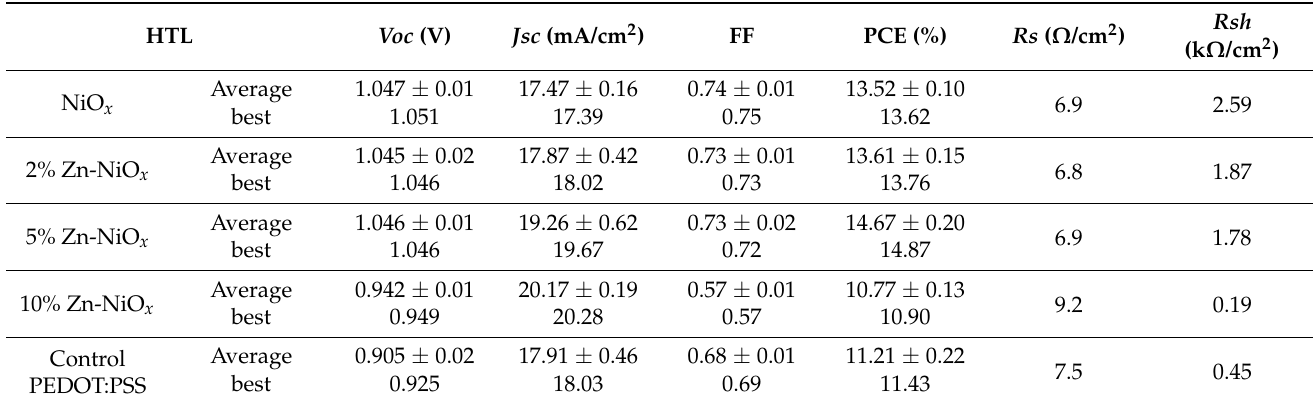
Table 1. Summary of device performance of the PSCs made with NiO x , Zn-NiO x , and PEDOT:PSS (control) HTLs.